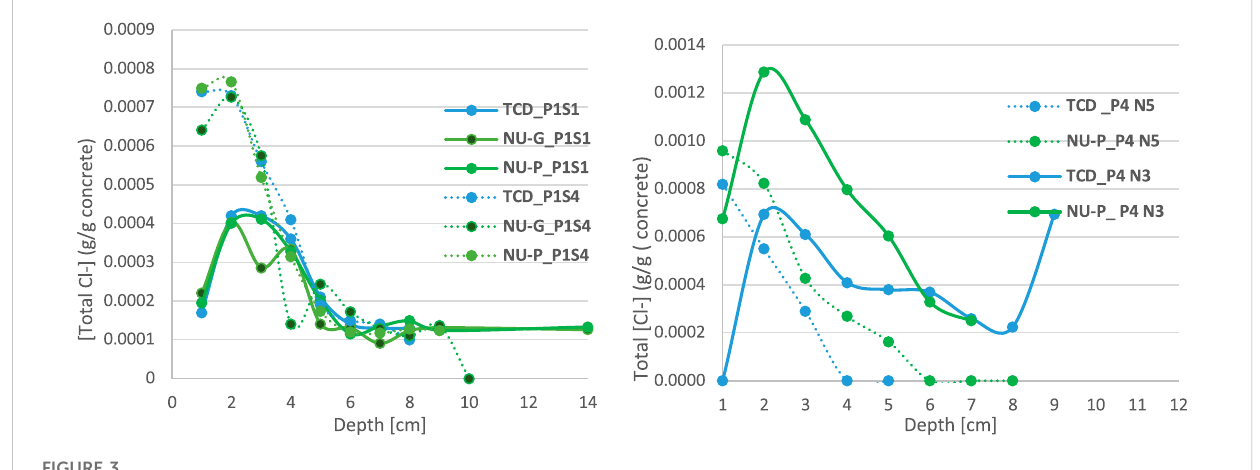
FIGURE 3 Example of total chloride pro fi les after 27 years of exposure showing the heterogeneity of measurements by different